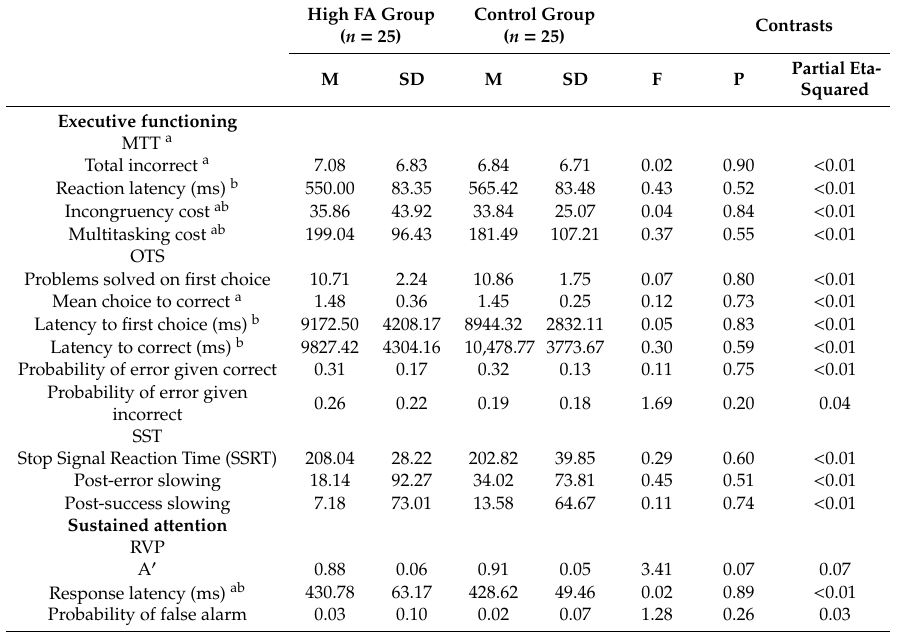
Table 2. Group comparisons–CANTAB neuropsychological tasks (high FA group vs. control group).